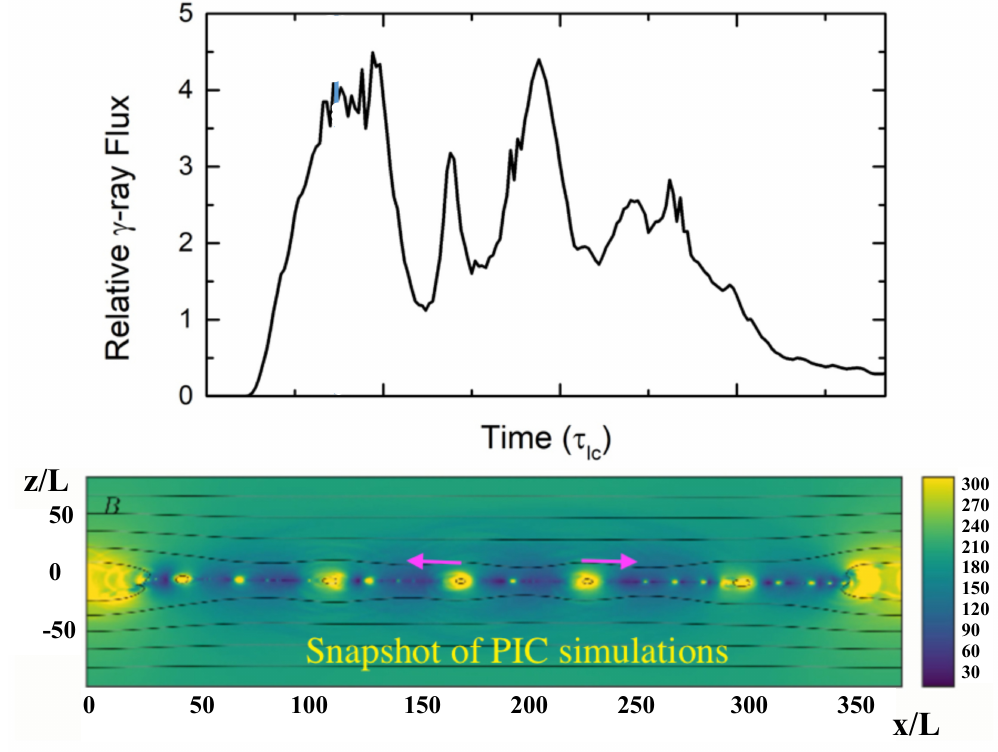
Figure 8. Radiative signatures of relativistic magnetic reconnection by an integrated modeling relying on first-principle particle-in-cell (PIC) kinetic simulation (Credit: Haocheng Zhang [98]). ( Top ) γ -ray light curve in units of light crossing time scale. ( Bottom ) reconnection layer in the unit of ion skin